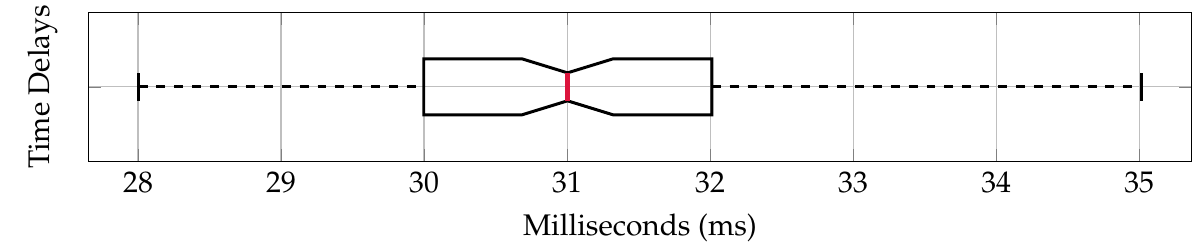
Figure 23. Time delay evaluation of the presented approach compared to a native implementation for triggering a GPIO during a benchmark with 100 iterations.